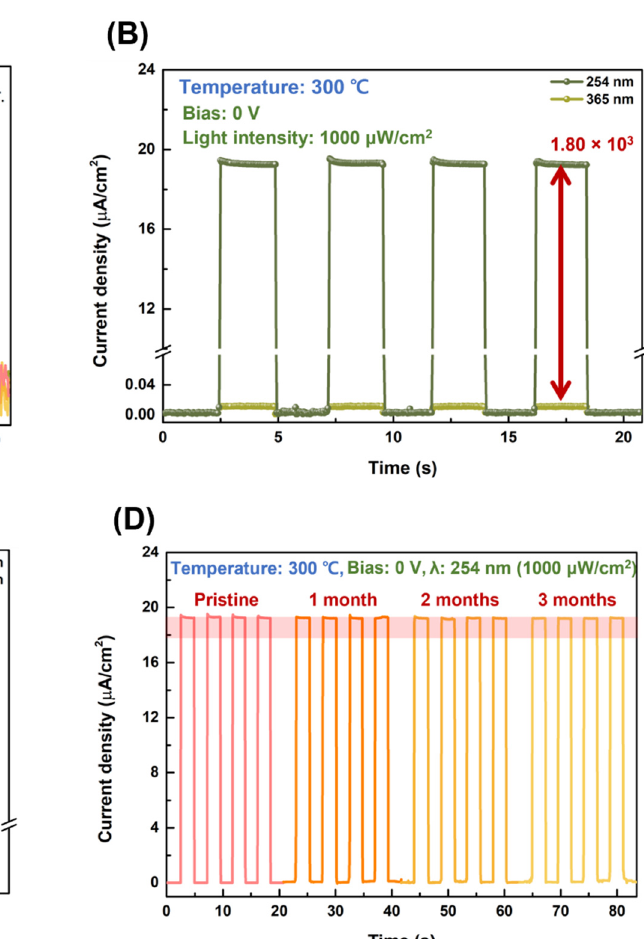
and 365 nm light with 1000 µ W/cm 2 light intensity; ( D ) photostability test for photodetector stored for three months at zero bias under 254 nm UVC light with 1000 μ W/cm 2 light intensity.